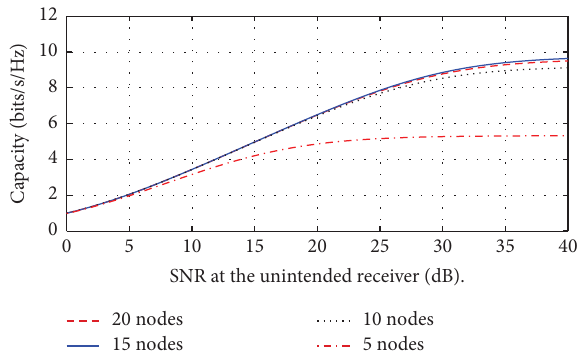
Figure 15: Capacity comparison: unintended receiver at (10 de- grees azimuth, 60 degrees elevation).